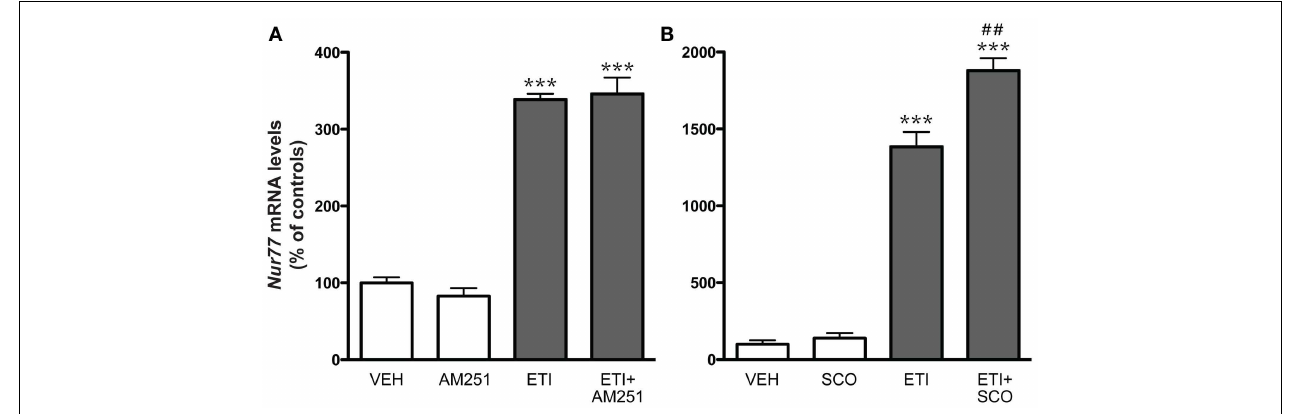
N = 5), or a combination of SCO and ETI. AM251 and SCO were administered 15min prior ETI. Histograms represent means ± SEM. Nur77 mRNA levels are expressed in% of control (VEH) in the ventrolateral portion of the striatum (*** p < 0.001 vs.VEH and ## p < 0.01 vs. ETI alone). Similar results were obtained in the other striatal subterritories (data not shown).